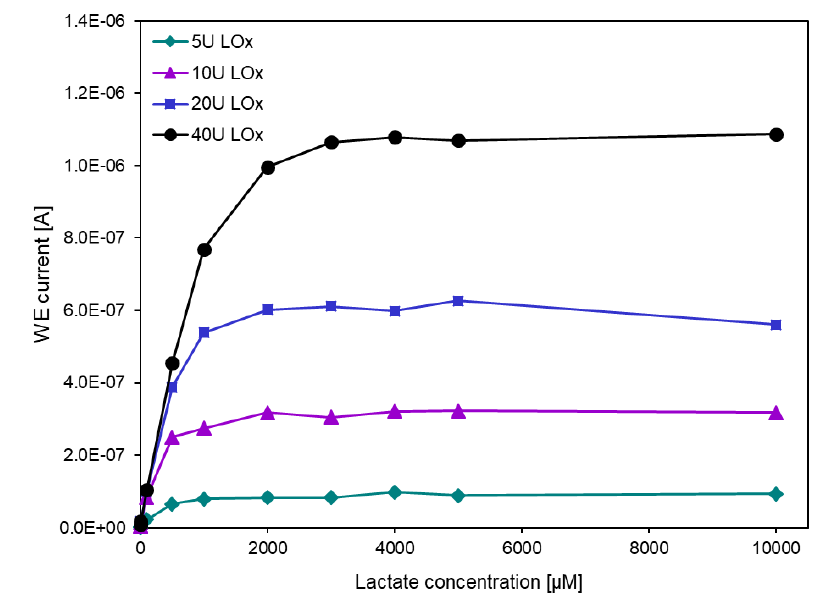
Figure A1. Amperometric L-lactate biosensor calibration curves (at potential 0.4 V and 180 s) in PBS with different enzyme loads on the sensor.